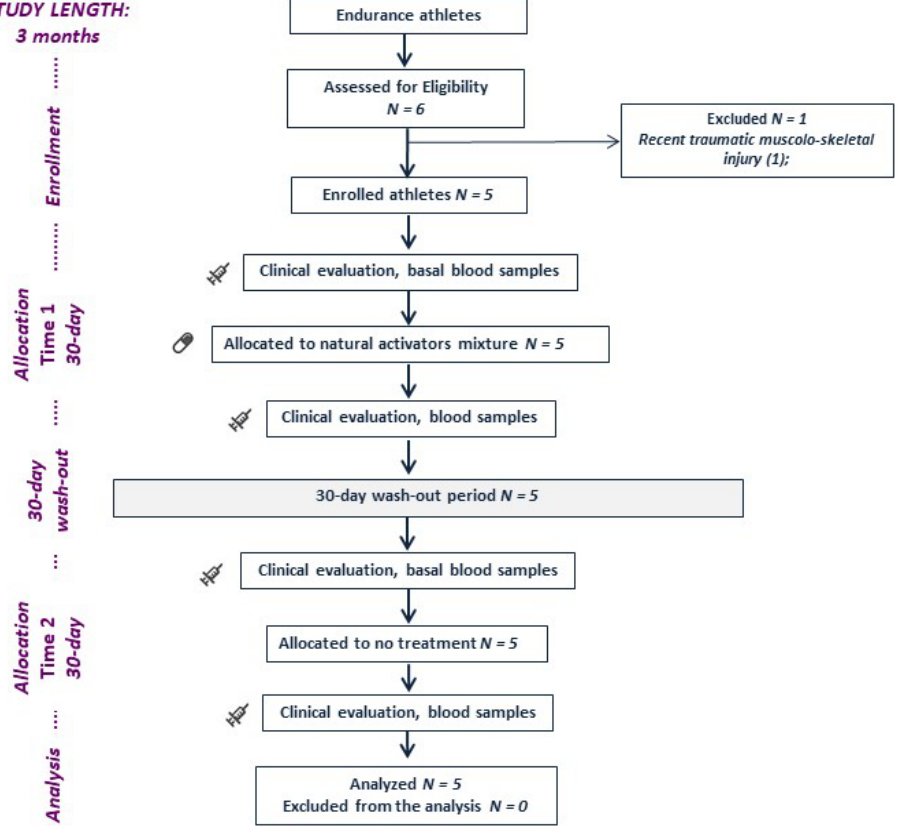
Figure 1. A schematic representation of the study